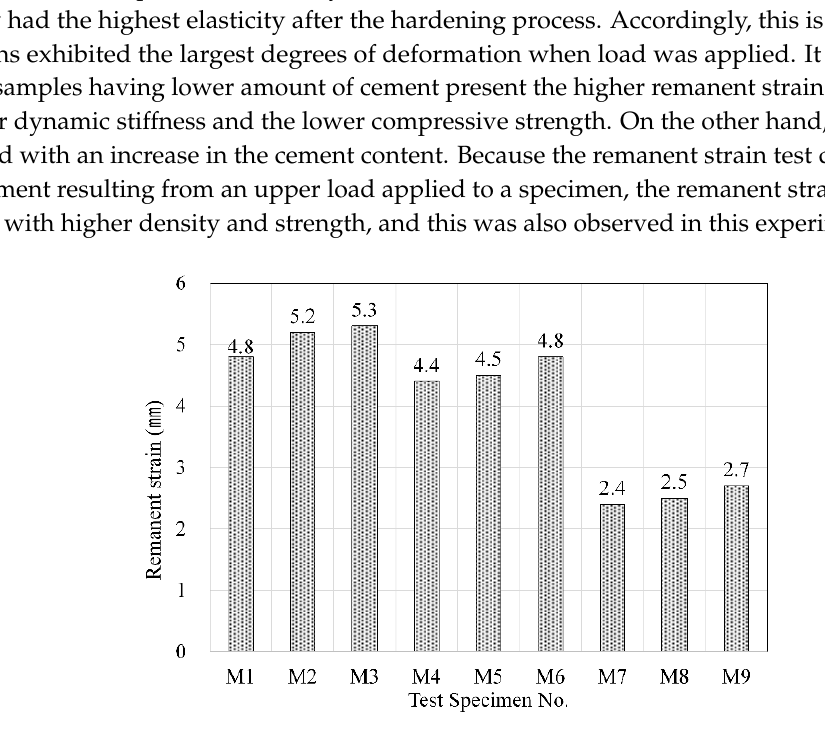
Table 10. Mix ratio of resilient materials for floor impact noise testing.